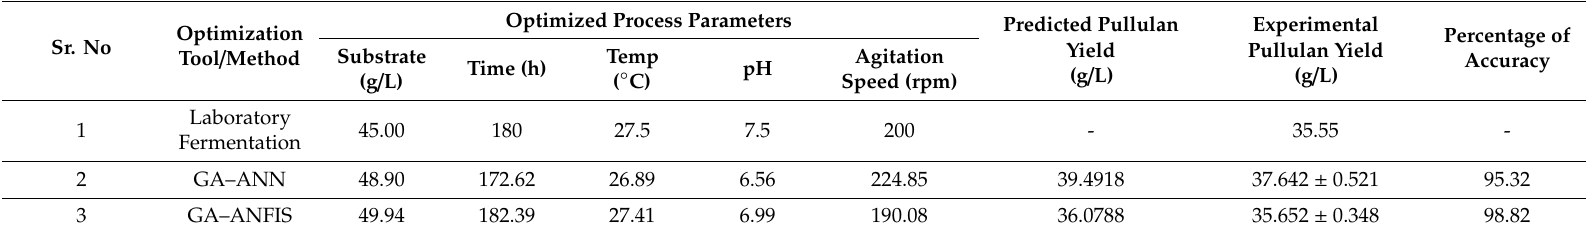
Table 4. Evaluation of optimization tools GA–ANN and GA–ANFIS with experimental data, with their optimized process parameters and outputs. Percentage accuracy of the 3 methods was also